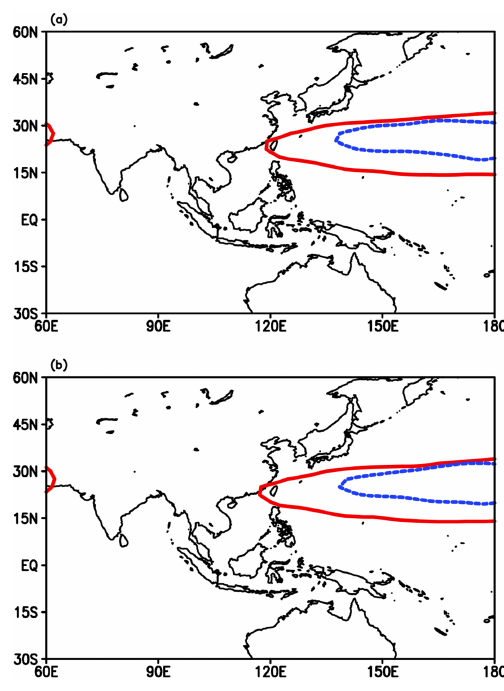
Figure 8. Composite lines of the summer 5870gpm in 500hPa for high (solid line) and low (short dotted line) R WNP/BOB (a) and R WNP/SCS (b)